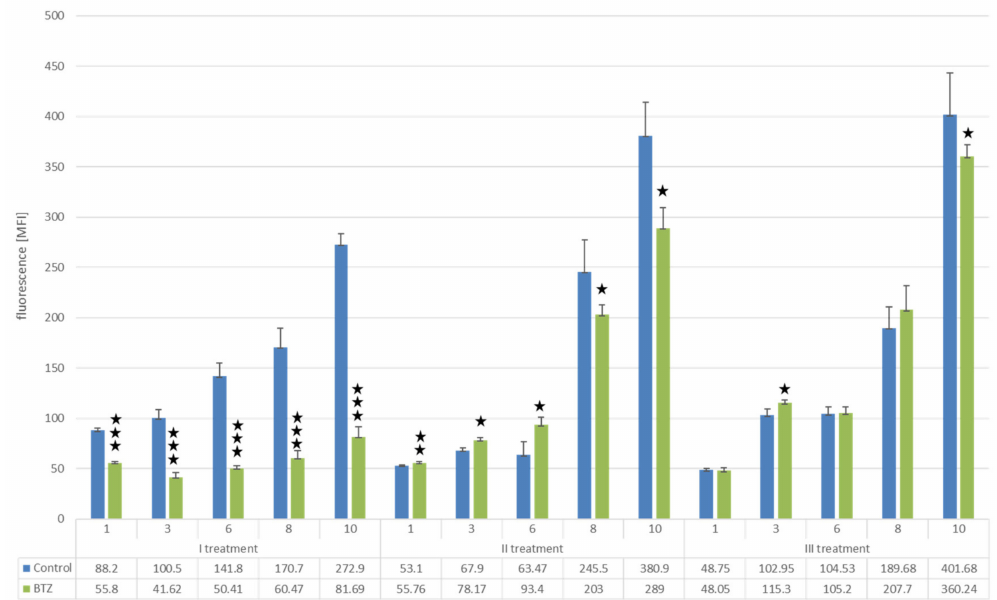
Figure 2. Analysis of U266 cell proliferation using the Alamar blue assay. The scheme shows the results after each treatment with BTZ or placebo (control). Measurements were taken 1, 3, 6, 8 and 10 days after treatment with the agents. Student’s t -test; *** p < 0.000001; ** p < 0.0001; * p < 0.05. Effect of Vitamins D and K on Proliferation of U266 Myeloma Cells The addition of 25(OH)D3 to the culture reduced the proliferation of myeloma cells after each incubation by more than 20% compared to control (on day 10 of cell culture: first incubation 25.21%, p < 0.001; second incubation 22.60%, p < 0.001; third incubation 24.42%, p < 0.0001) (Figure 3).